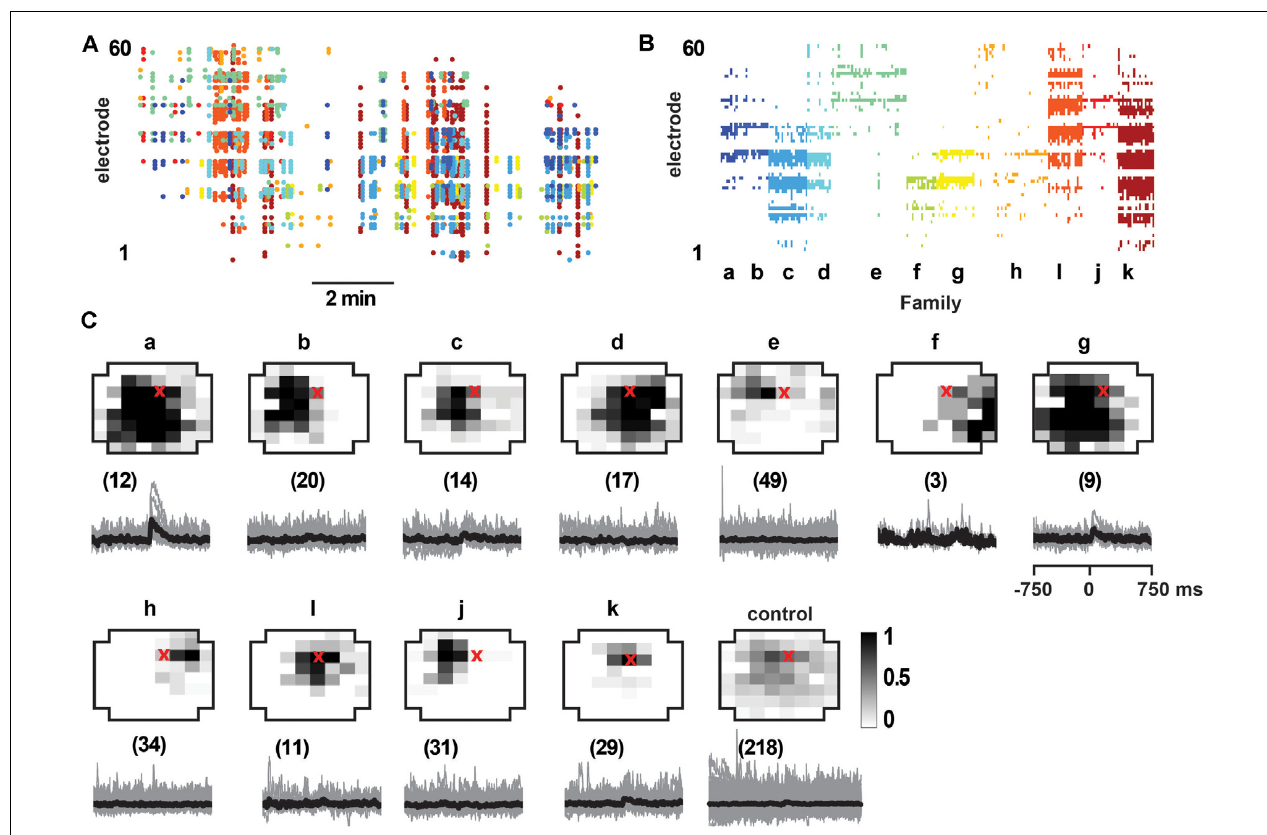
FIGURE 8 | Select responses in layer 2/3 pyramidal neurons to avalanche families in normal ACSF from young slices. (A) nLFP raster on the MEA with color-coded avalanche families and their temporal occurrences during spontaneous activity in young slices (10 min recording, M1). Note higher rate of avalanche occurrence compared to slices from adult rats (see Figure 7 ). (B) Corresponding family-sorted avalanche raster. (C) Top: average spatial LFP pattern for all avalanche families. Grayscale indicates the fraction of site participation for each family. The red cross marks the soma location of the patched pyramidal neuron. Control includes all avalanches except those in families a, g . Bottom: family-triggered average intracellular membrane potential time course ( black ). The number in brackets indicates family members. Pre-averaged individual traces are shown in gray . Note that families d and i do not reveal significant intracellular responses despite substantial spatial overlap with soma location. Families a and g correlated with reliable intracellular responses in the patched pyramidal neuron. Corresponding control demonstrates no reliable trigger with non- a , g